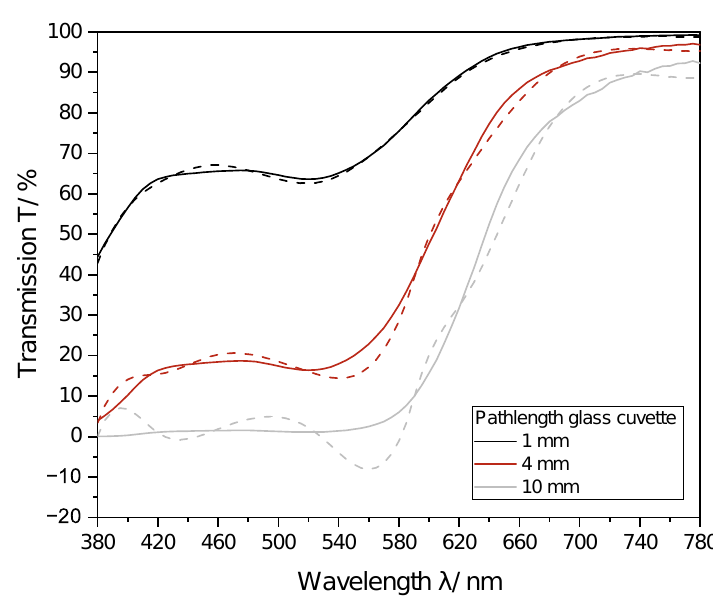
Figure 9. Influence of pathlength of the cuvette on the interpolation of the transmission spectrum via cubic splines for a red wine. Measured was a Pinot Noir (2019) from Germany. The measured spectrum (solid line) and the interpolated spectrum (dashed line) for different pathlengths of glass cuvettes are shown. The spectrum was recorded with a 1 mm, 4 mm, and 10 mm glass